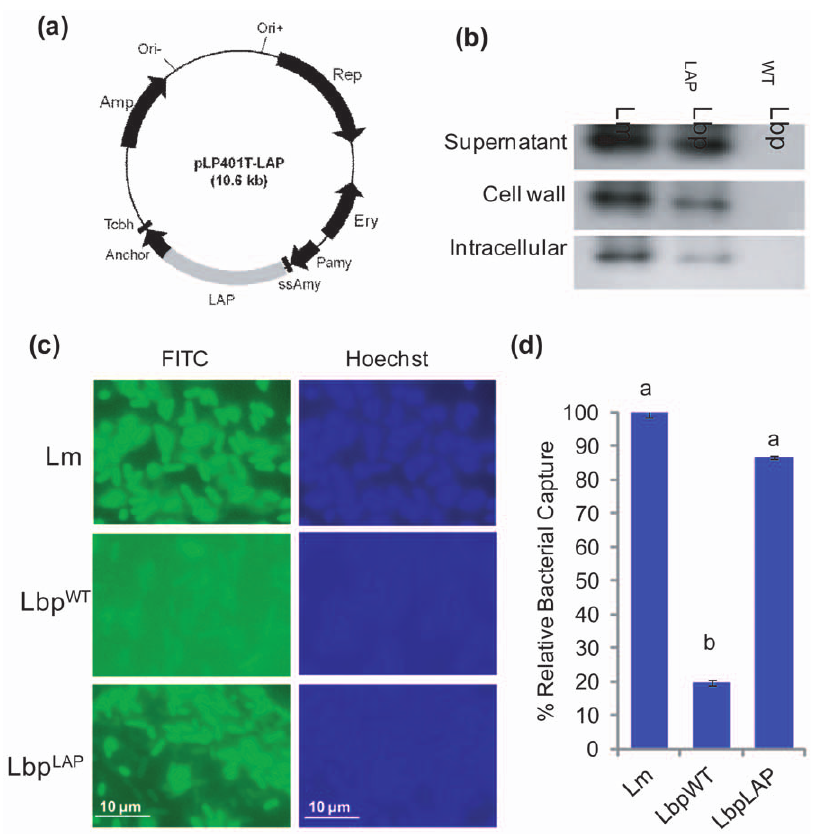
Figure 2. Listeria adhesion protein (LAP) expression analysis in recombinant Lactobacillusparacasei (Lbp LAP ). (a) Plasmid map (10.6 kb) of LAP expression vector pLP401T (9.8 kb)-LAP (2.6 kb) [50]. Ery , erythromycin resistance gene; Amp , ampicillin resistance gene; Ori + =origin of replication of E. coli , Ori-= origin of replication of Lactobacillus ; LAP , Listeria adhesion protein; Pamy , a -amylase promoter gene; ssAmy , secretion signal (36 aa) and the N-terminus (26 aa) of a -amylase gene; Anchor , anchor peptide (117 aa) gene of Lb. casei ; Tcbh , transcription terminator of the cbh (conjugated bile acid hydrolase) gene; Rep , repA gene. (b) Western blot showing LAP expression in the supernatant, cell wall, and intracellular fractions of Listeria monocytogenes (Lm) and Lbp LAP but absent in wild type Lb. paracasei (Lbp WT ). Molecular weight of LAP from Lm and the recombinant Lbp LAP was similar. (c) Immunofluorescence staining of bacteria (magnification 1000 6 ) with anti-LAP MAb-H7 and fluorescein isothiocyanate-conjugated second antibody (left panel) and Hoechst dye (blue; right panel). Lbp LAP and Lm (control) cells indicated the presence of surface-expressed LAP (green) that was absent in Lbp WT . (d) Binding (capture) of recombinant Lb. paracasei cells to paramagnetic beads coated with Hsp60 relative to L. monocytogenes (considered 100%). The data are average (SD) of two independent experiments performed in duplicate. Letters (a, b) indicate significant difference at P , 0.05.